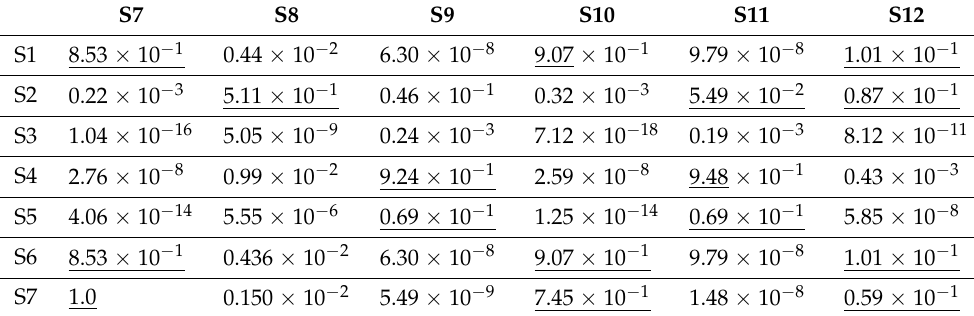
Table 11. t -test results for subjects